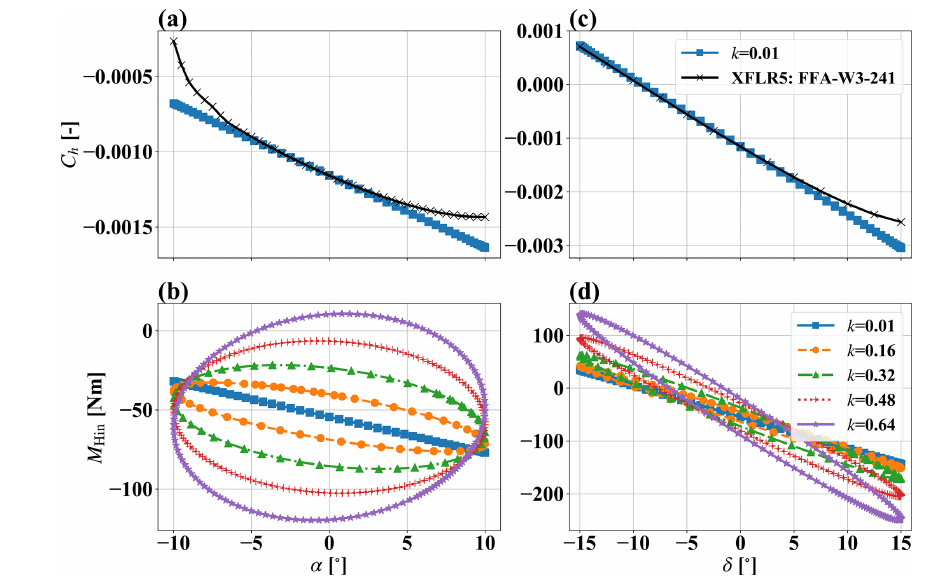
Figure 3. (a) C h vs. α with δ = 0 ◦ from XFLR5 results and from quasi-steady model simulations. (b) M Hin vs. α for several reduced freqs. k and δ = 0 ◦ . (c) C h vs. δ with α = 0 ◦ from XFLR5 results and from quasi-steady model simulations. (d) M Hin vs. δ for several reduced freqs. k and α = 0 ◦